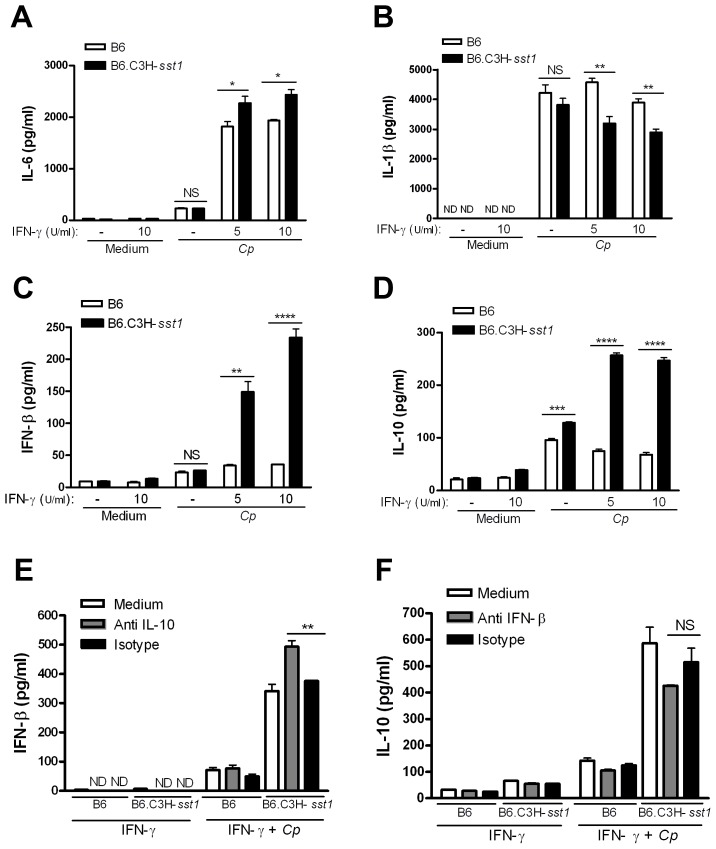

In vitro cytokine production from C. pneumoniae infected BMDM.BMDMs were prepared from C57BL/6 (B6) or B6.C3H-sst1 congenic mice, as described in the Methods. Cells were infected with C. pneumoniae at an MOI of 3∶1, and supernatant harvested at 24 hpi for assay of the indicated cytokines. (A–D) In some cases, cells were pretreated with IFN-γ for 30 min at the indicated concentrations prior to infection. (E–F) For antibody neutralization, cells were pretreated with indicated neutralizing antibody (anti-IL-10 or anti-IFN-β) or isotype control at a concentration of 250 ng/ml prior to infection or IFN-γ treatment (10 U/ml). Data is shown as the mean ± SEM from triplicate wells. Significance: NS, No significant difference; *, p<0.05; **, p≤0.01; ***, p≤0.001; ****, p≤0.0001. The results are representative of at least 3 independent experiments.